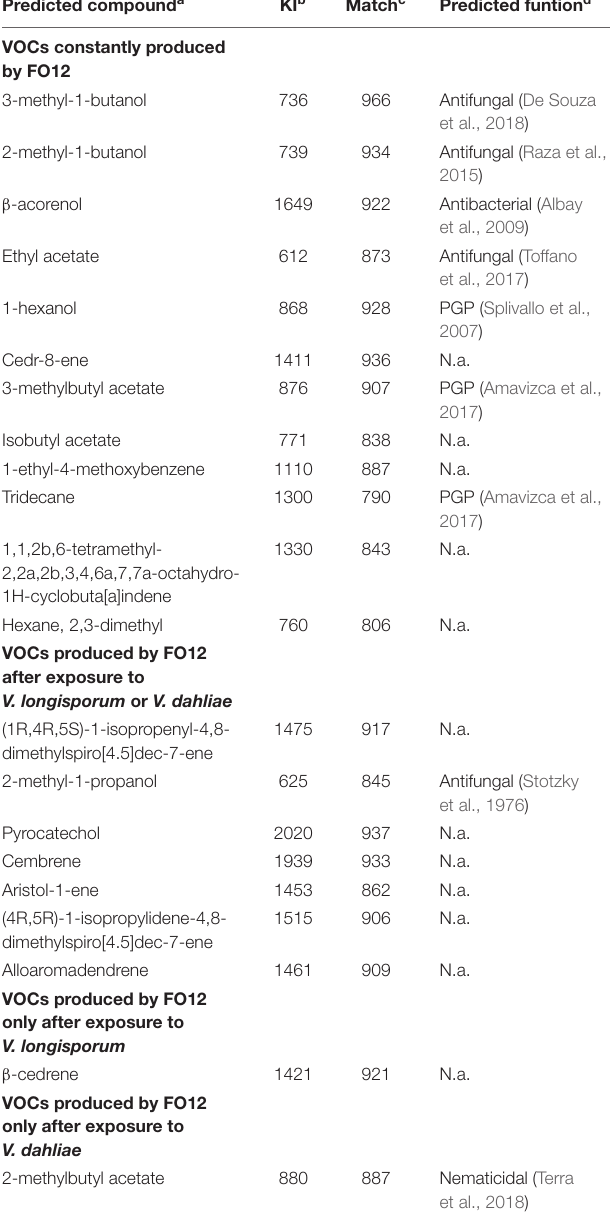
TABLE 1 | GC-MS headspace SPME identification of relevant VOCs produced by the non-pathogenic F. oxysporum FO12 alone and during co-incubation with V. longisporum ELV25 or V. dahliae